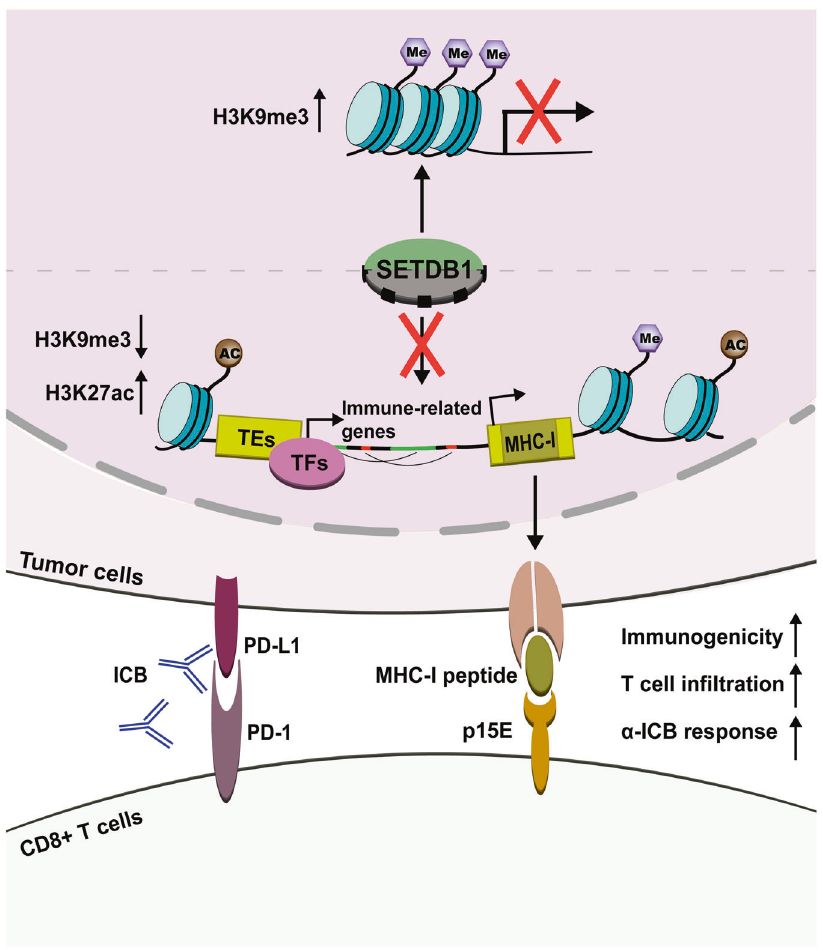
Fig. 1 The schematic of SETDB1 repression in promoting the cytotoxic T-cell responses against tumor. Inhibition of SETDB1 induces extensive TEs expression and segmental duplications that not only activate immune-related genes but also encode MHC-I peptides as neoantigens, leading to the enhanced immunogenicity and killing susceptibility of tumor cells. Me methylation, Ac acetylation, TEs transposable elements, TFs transcriptional factors, ORF open reading frame, ICB immune checkpoint